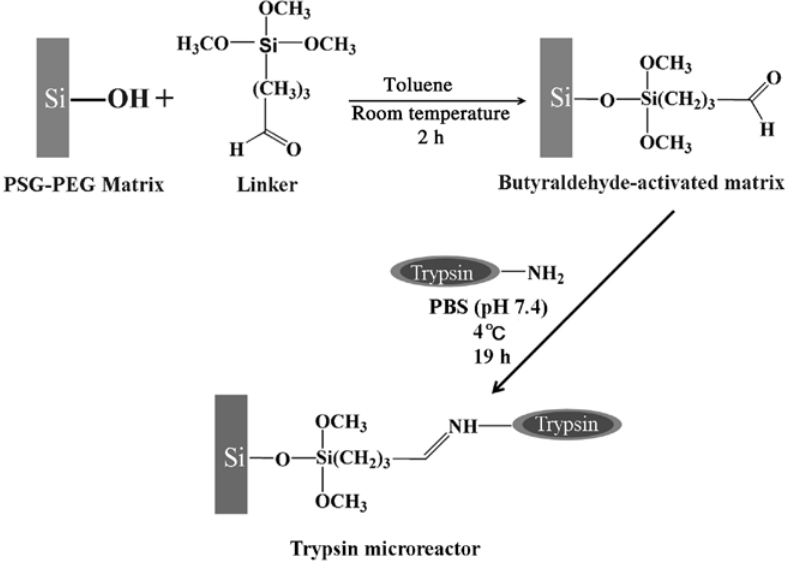
Figure 6: Strategies for functionalization of the PSG-PEG monolith surface with trimethoxysilylbutyraldehyde linker and attachment of trypsin to a butyraldehyde-activated PSG-PEG monolith. This figure was reproduced with permission from Dulay et al. (2005). Copyright © 2005 American Chemical